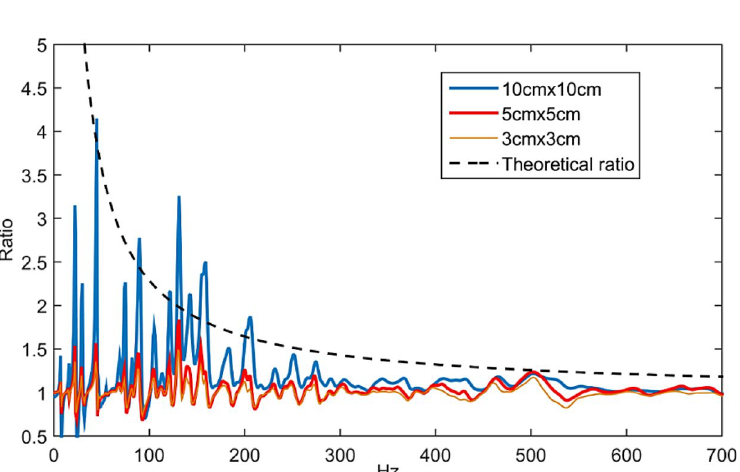
Figure 9. Uncontrolled/controlled plate energy when attached with optimal PZT shunt damper at different sizes, compared with theoretical energy ratio as derived in Eq.